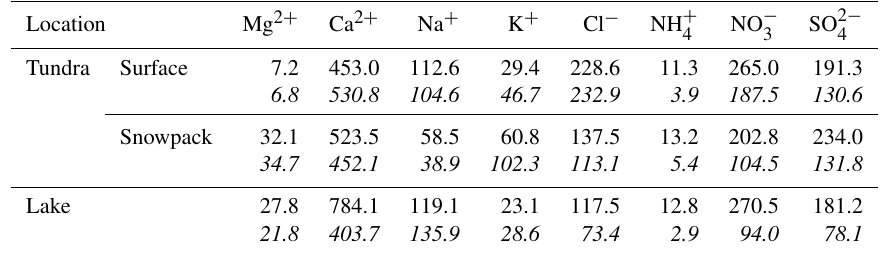
Table 1. Mean concentration (µgL − 1 ) , including standard deviation (italics), of cations and anions in tundra and lake snowpack and in surface snow at Toolik Field Station.